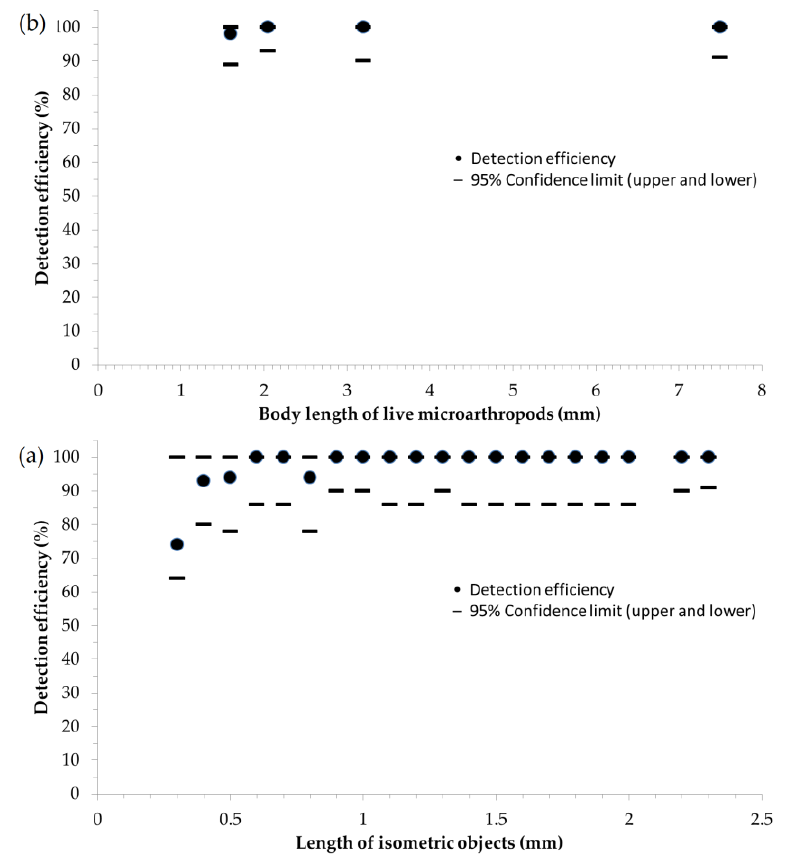
Figure 5. ( a ) Detection efficiency of isometric granules in twenty, distinct size categories (the number of samples are between 20–70 in these size categories). ( b ) Detection efficiency of soil microarthropods in four, distinct size categories (the number of samples are between 30–44 in these size categories). Dash lines show the lower and upper 95% confidence limits of detection efficiency.